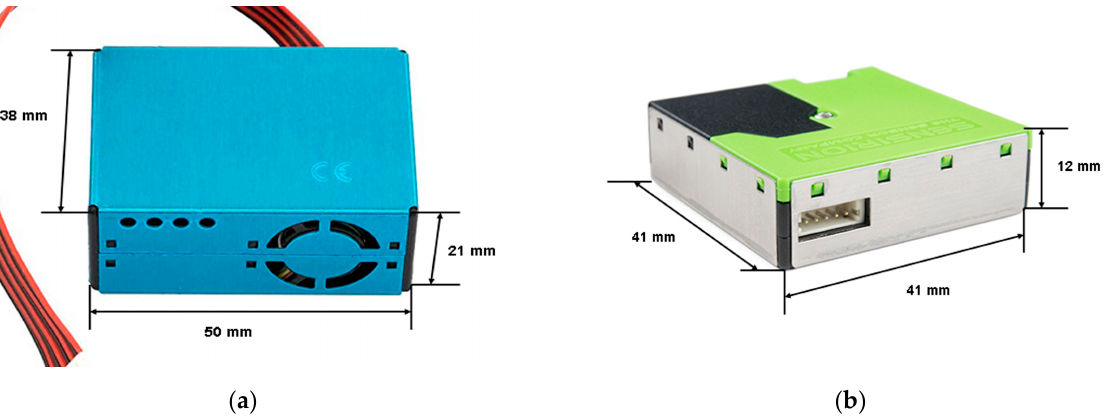
Figure 3. The simplified scheme of an optical counter for PM detection on which the working principle of LCSs used in this research is based. Other LCMs similar to SentinAir are currently available on the market. These are all based on LCSs whose working principle follows the simplified scheme depicted in Figure